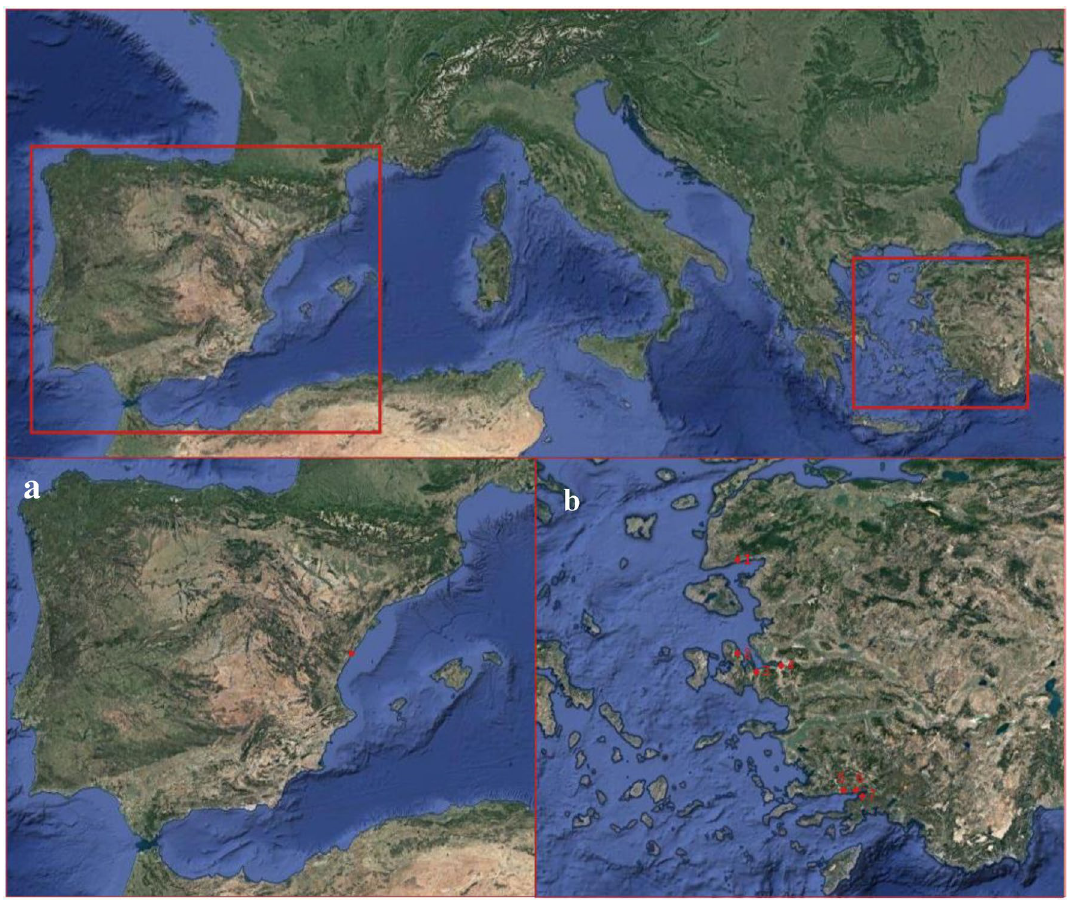
Figure 3. ( a ) Castelló de la plana’s location; ( b ) Fishery cooperatives data collected in the Aegean Sea: (1) Altınoluk, (2) Mordoğan, (3) Urla, (4) Bostanli, (5) Akbük, (6) Akyaka, (7)